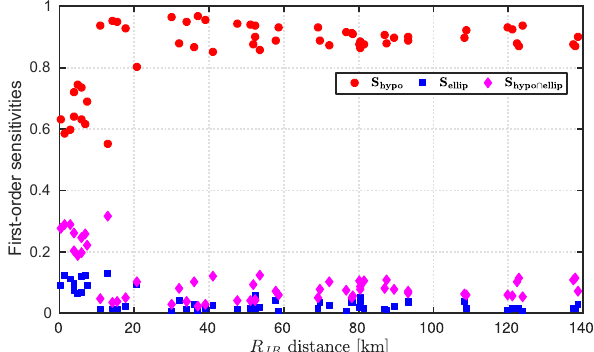
Figure 8. First-order sensitivity indices with respect to grouped pa-